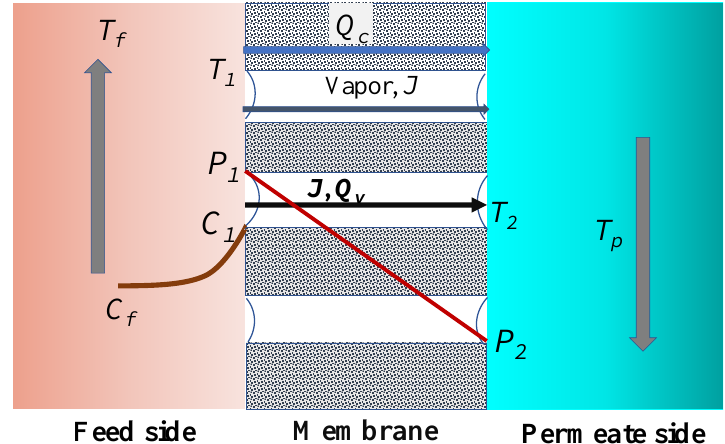
Figure 3. Schematic diagram of heat transfer and mass transfer in DCMD.